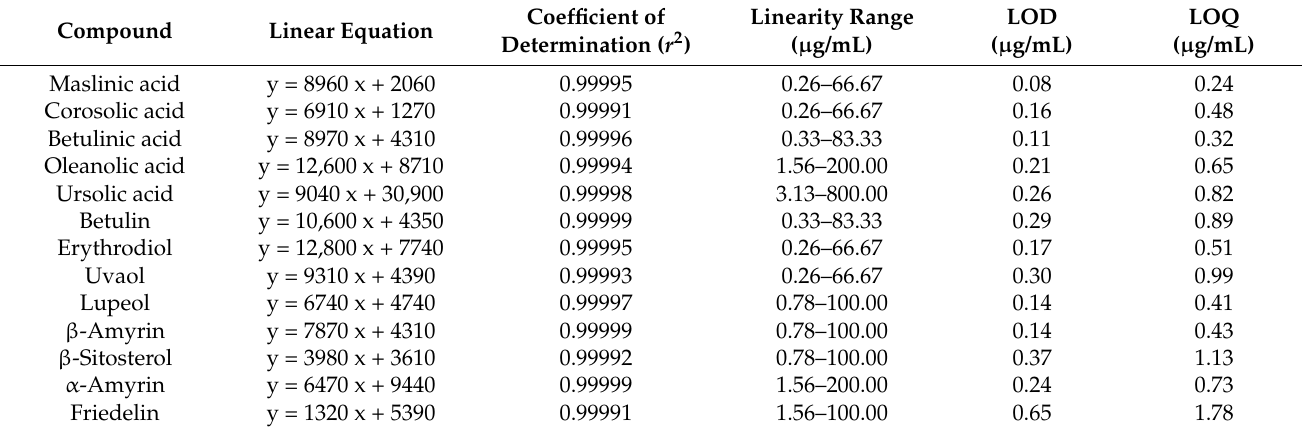
Table 1. Linearity and sensitivity data of